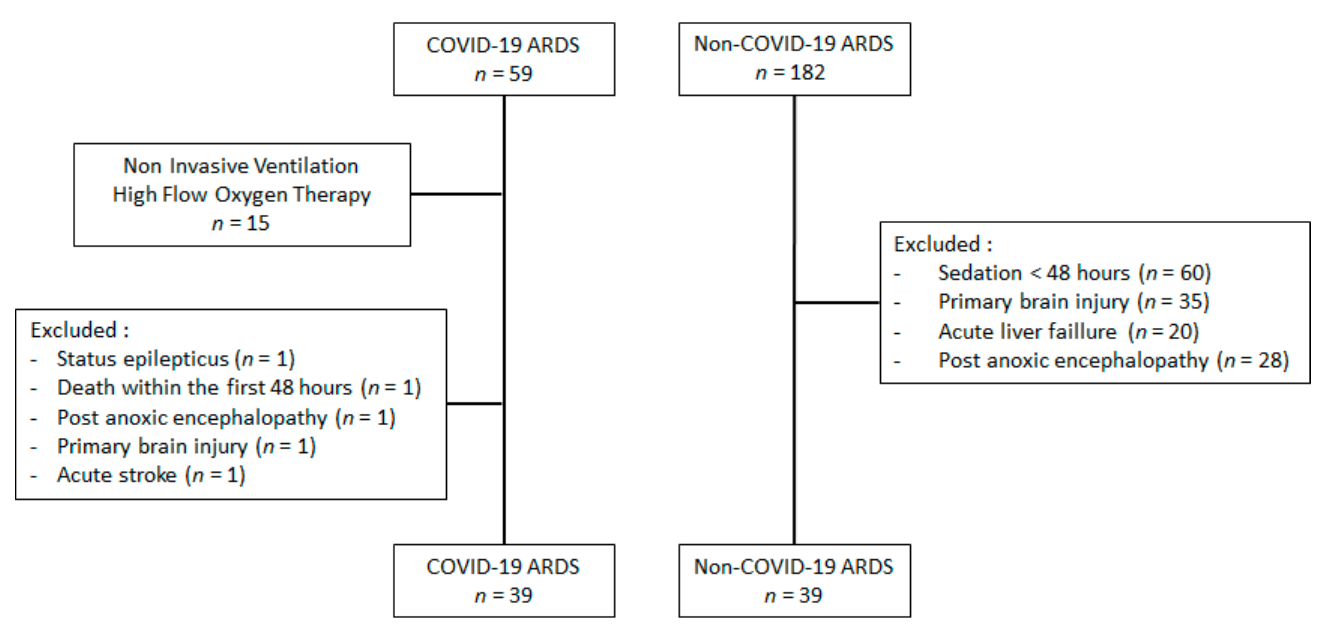
Figure 1. Flow chart of the study.